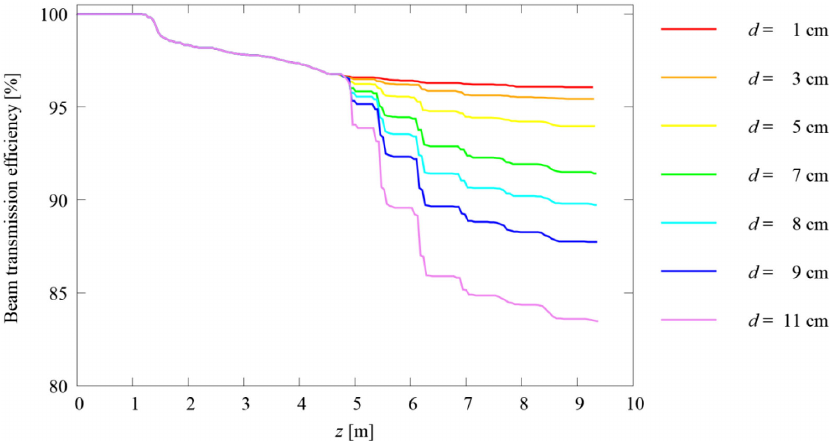
FIG. 7. Beam transmission curves for different drift lengths ( d ¼ 1 – 11 cm).